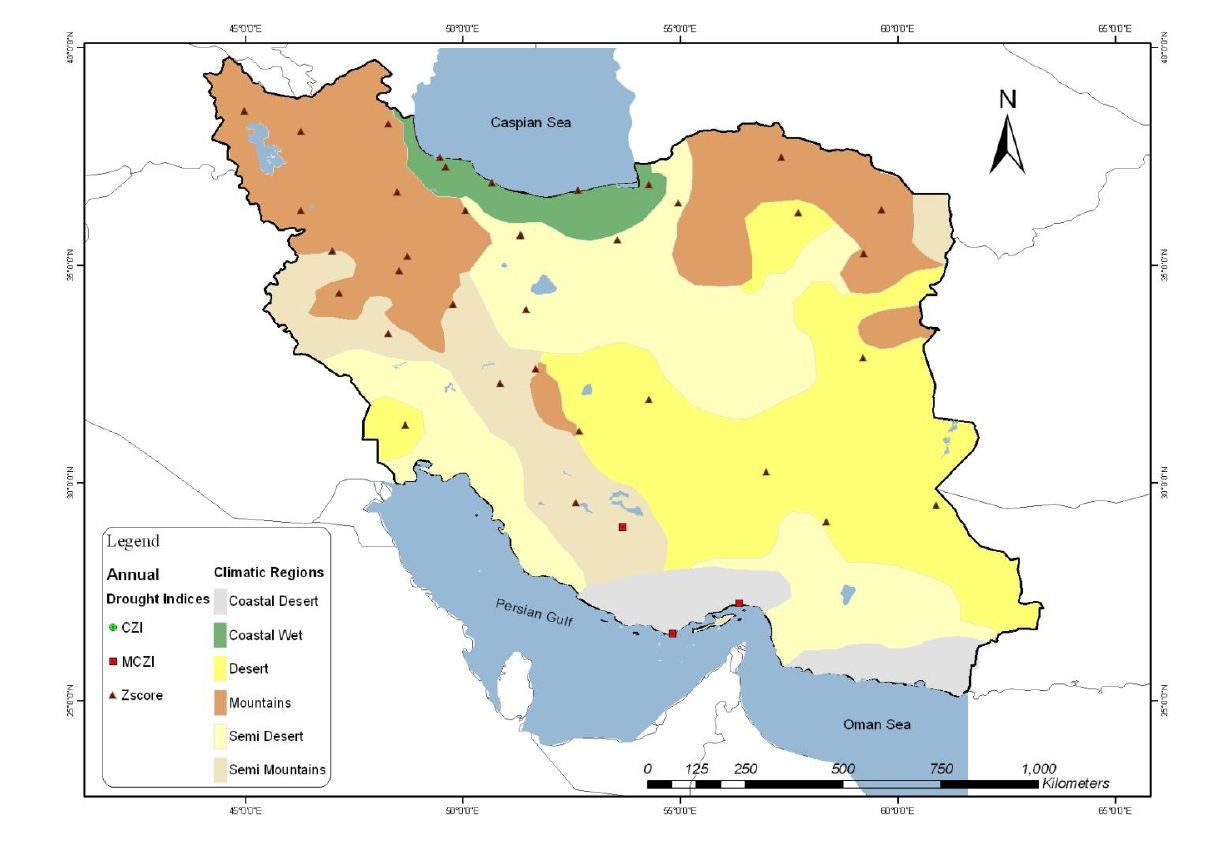
Figure 7. Spatial distribution of annual drought indices with the best correlation to